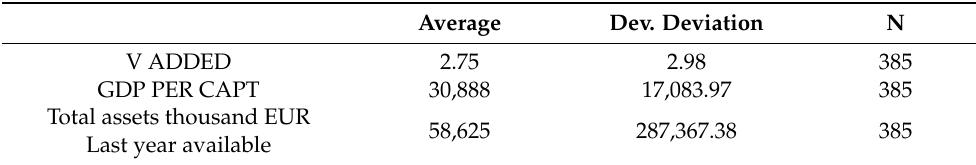
Table 8. Descriptive statistics (a). Source: own development.